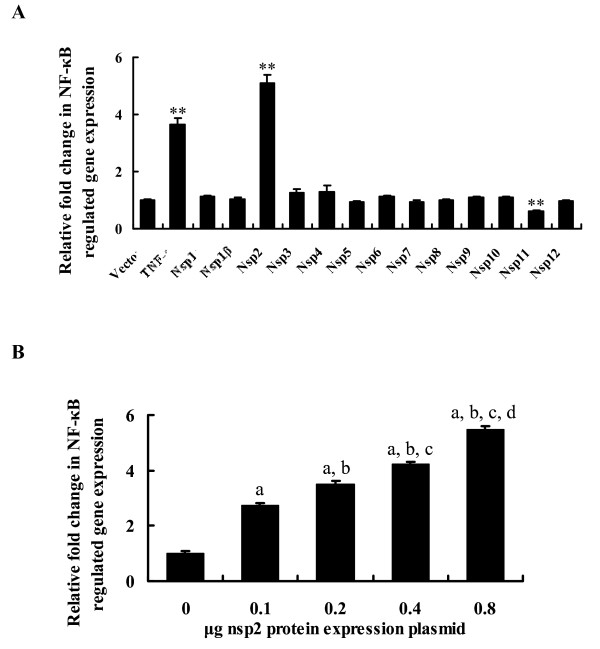
PRRSV Nsp2 activates NF-κB. (A) HeLa cells were co-transfected with the NF-κB-Luc reporter plasmid (0.2 μg), pRL-TK plasmid (0.05 μg), along with 0.6 μg of the indicated expression plasmid encoding PRRSV nonstructural protein. Selected cells were stimulated by 20 ng/ml TNF-α at 30 h post-transfection, and whole-cell extracts were prepared for the dual-luciferase activity at 6 h after this treatment. **P < 0.01 as compared with vector control. (B) An increasing quantities of indicated Nsp2 expression plasmid (0, 0.1, 0.2, 0.4, 0.8 μg) was co-transfected with pNF-κB-Luc and pRL-TK into HeLa cells. Cells were harvested at 36 h after transfection and analysed for luciferase activity. (a) P < 0.05 compared with the vector group, (b) P < 0.05 compared with 0.1 μg Nsp2 protein transfection group, (c) P < 0.05 compared with 0.2 μg Nsp2 protein transfection group, (d) P < 0.05 compared with 0.4 μg Nsp2 protein transfection group. Values for the samples were normalized using Renilla luciferase values and expressed as relative fold change in NF-κB-regulated gene expression compared with vector group, and each untreated empty vector control value was set as a basis level of 1. Data represent means of three replicates and results are representative of at least three independent experiments.